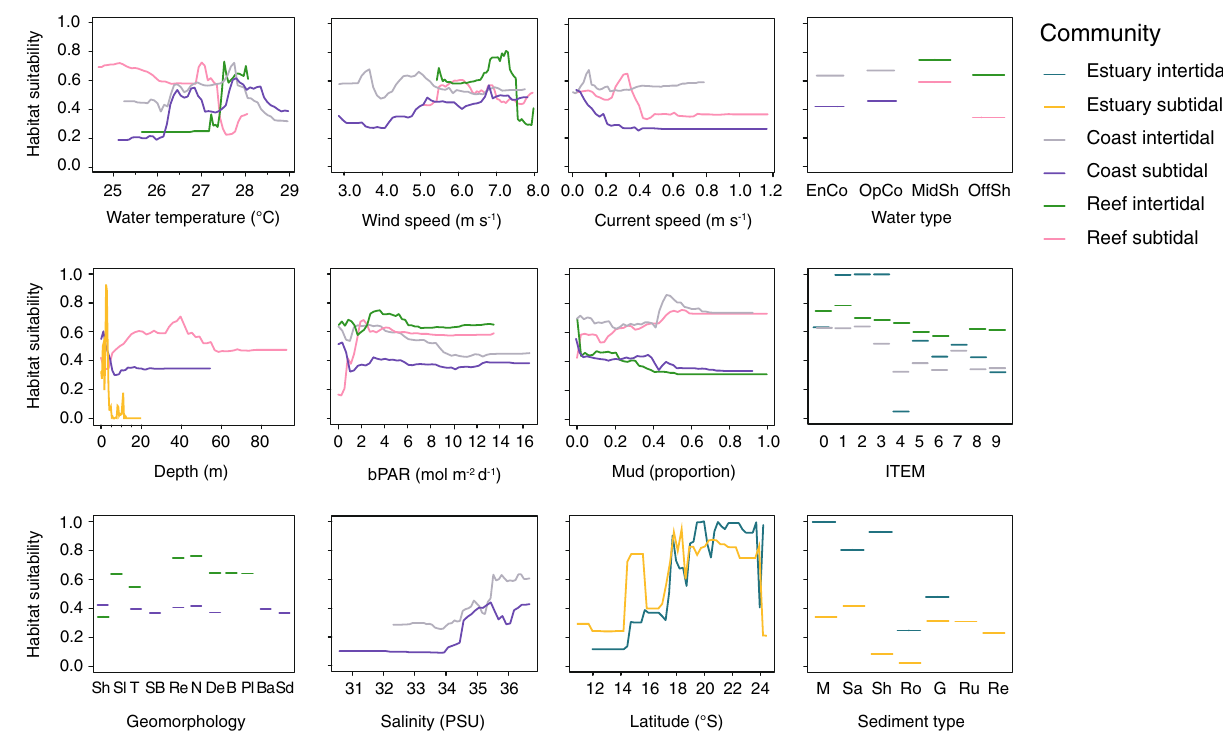
Figure 2. Partial plots of variable importance from six Random Forest models. Abbreviations for factor levels are: Water type ( EnCo enclosed coastal, OpCo open coastal, MidSh midshelf; OffSh offshore); Geomorphology ( Sh shelf, Sl slope, T terrace, SB sand bank, Re reef, N N/A beyond the extent of the layer or on land, De deep hole or valley, B basin, Pl plateau, Ba basin, Sd saddle); and Sediment ( M mud, Sa sand, Sh shell, Ro rock, Ru rubble, Re Island (17.81°–18.46° S), the mixed species community EI3 between Hinchinbrook Island and northern Cur- tis Island (23.57° S), and the H. ovalis and Z. capricorni dominated community EI5 from Curtis Island south (Figs. 3 and 5f; Table 3). An additional four intertidal communities were predicted where tidal exposure was low (ITEM = 2–3): the Z. capricorni dominated community EI8 north of Mourilyan Harbour, the H. uninervis dominated community EI6 between Mourilyan Harbour and Townsville (17.62°–19.28° S), the extensive Z. cap- ricorni dominated community EI7 between Townsville and Shoalwater Bay (156 km 2 ), and the Z. capricorni and H. uninervis dominated community EI9 south of Shoalwater (19.28° S) (Figs. 3 and 5; Table 3). Estuary subtidal. The estuary subtidal model predicted six seagrass communities (Figs. 3 and 5; Table 3). Community ES1 is the most extensive, predicted to cover a total subtidal area of 182 km 2 in depths below 2.9 m mean sea level (MSL). This is the only deep estuarine subtidal community predicted to occur, and it is dominated by H. ovalis and/or Halophila decipiens with no Z. capricorni (Figs. 4b and 5). Other subtidal communities occur in depths shallower than 2.9 m (Fig. 5e). Between Hinchinbrook Island (18.37° S) and Gladstone, community ES2 is predicted in the intermediate depth range 1.6–2.9 m MSL and has a species mix similar to the deep estuarine community ES1 but with the addition of Z. capricorni , and community ES3 is predicted in the 0–1.6 m MSL depth range with Z. capricorni and H. ovalis . From Hinchinbrook Island north, subtidal communities were predicted to occur in distinct latitudinal bands similar to intertidal communities: the small H. ovalis community ES6 (16 km 2 ) between central and northern Hinchinbrook Island (18.37°–18.27° S), the H. ovalis / H. decipiens community between northern Hinchinbrook Island and Trinity Inlet, and the mixed species community ES5 north of Trinity Inlet (16.92° S) (Figs. 3 and 5, Table 3). Coastal intertidal. The coastal intertidal model predicted communities separated by variations in water type, water temperature, salinity and tidal exposure (Fig. 6). Three communities were predicted within the enclosed coastal water type: in cooler (< 26.4 °C) southern GBRWHA waters the H. ovalis and Z. capricorni dominated community CI1; in warmer waters the Z. capricorni community CI2 where tidal exposure is low (ITEM = 2–3) and the more speciose community CI3 where tidal exposure is very low (ITEM = 0–1) or inter- mediate to high (ITEM = 4–9) (Figs. 3 and 6, Table 3). Three communities were also predicted within the open coastal water type. Community CI4 is predicted to occur throughout the GBRWHA where salinity is < 35.4 PSU and, unusually for coastal communities, this speciose community has relatively high frequency of T. hem- prichii and C. rotundata, species usually associated with intertidal reef communities. Communities CI5 and CI6 were predicted to occur in regions of high salinity between Townsville and the Keppel Islands: Community